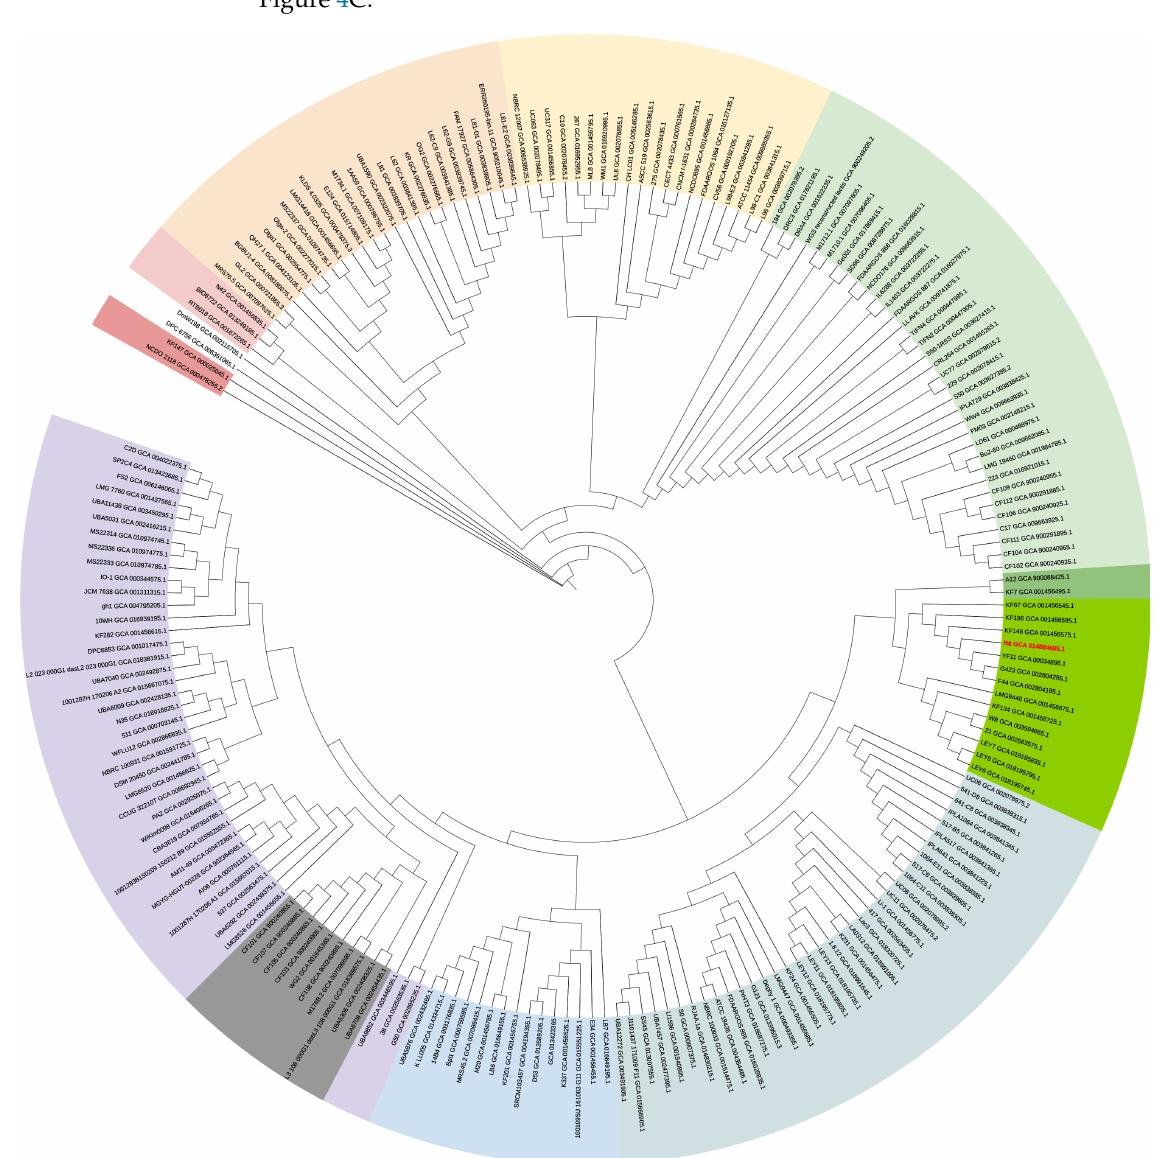
Figure 2. Overall position of L. lactis N8 in the L. lactis phylogeny. An unrooted tree, representing the phylogenetic position of N8 (red) among 202 L. lactis